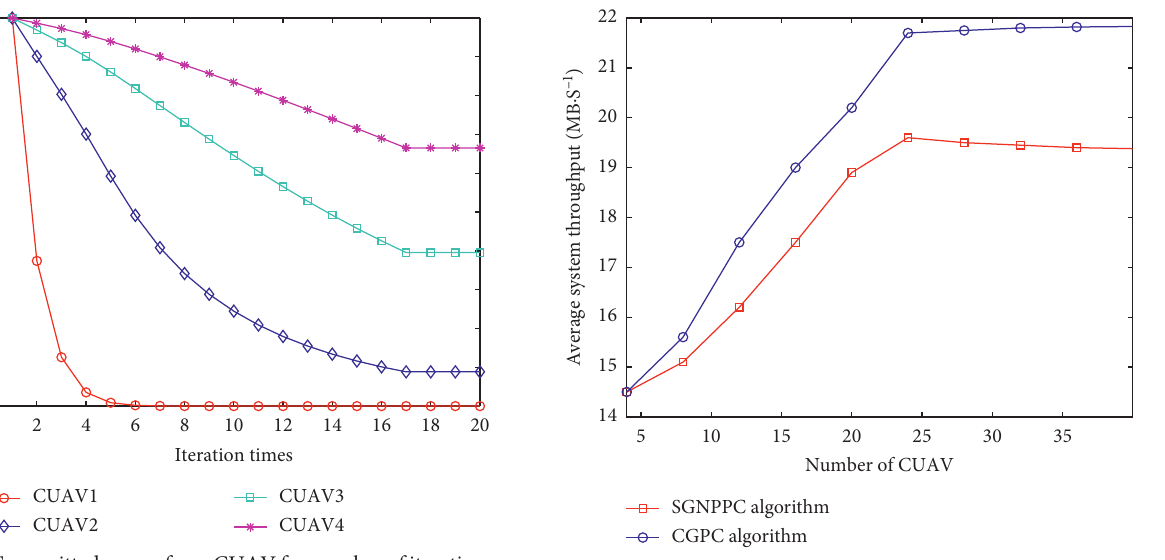
Distance between EUi and CUAV i